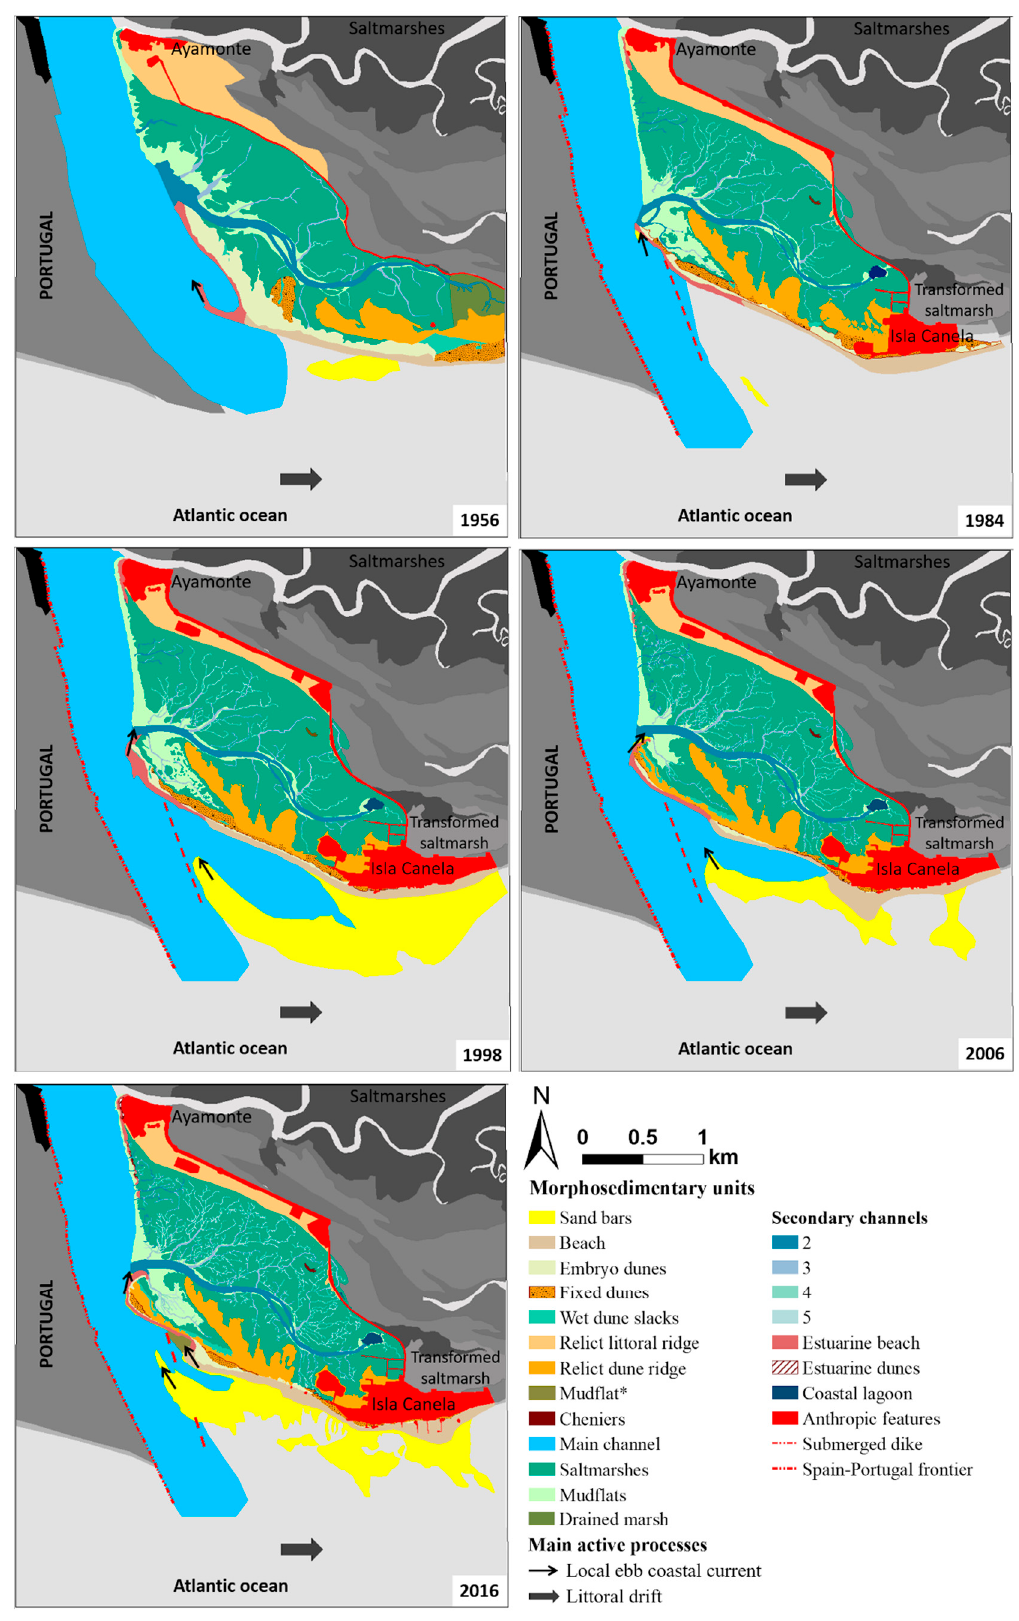
Figure 3. Historical evolution of the eco-geomorphological features identified in Guadiana River estuary (1956–2016). The symbol * after a feature name indicates that such a feature is still developing.